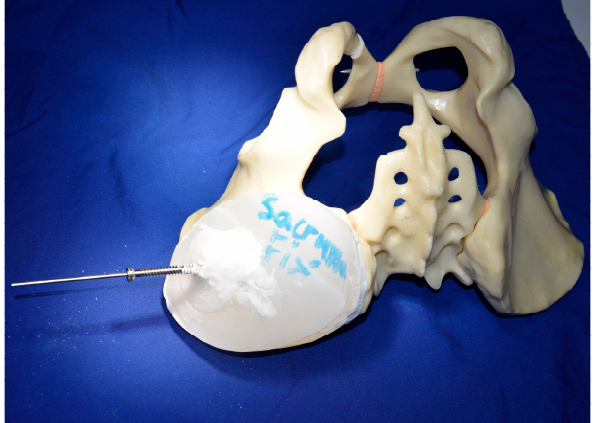
Figure A1. All osteotomies were set using a customised cutting template ensuring consistent course of fracture lines.